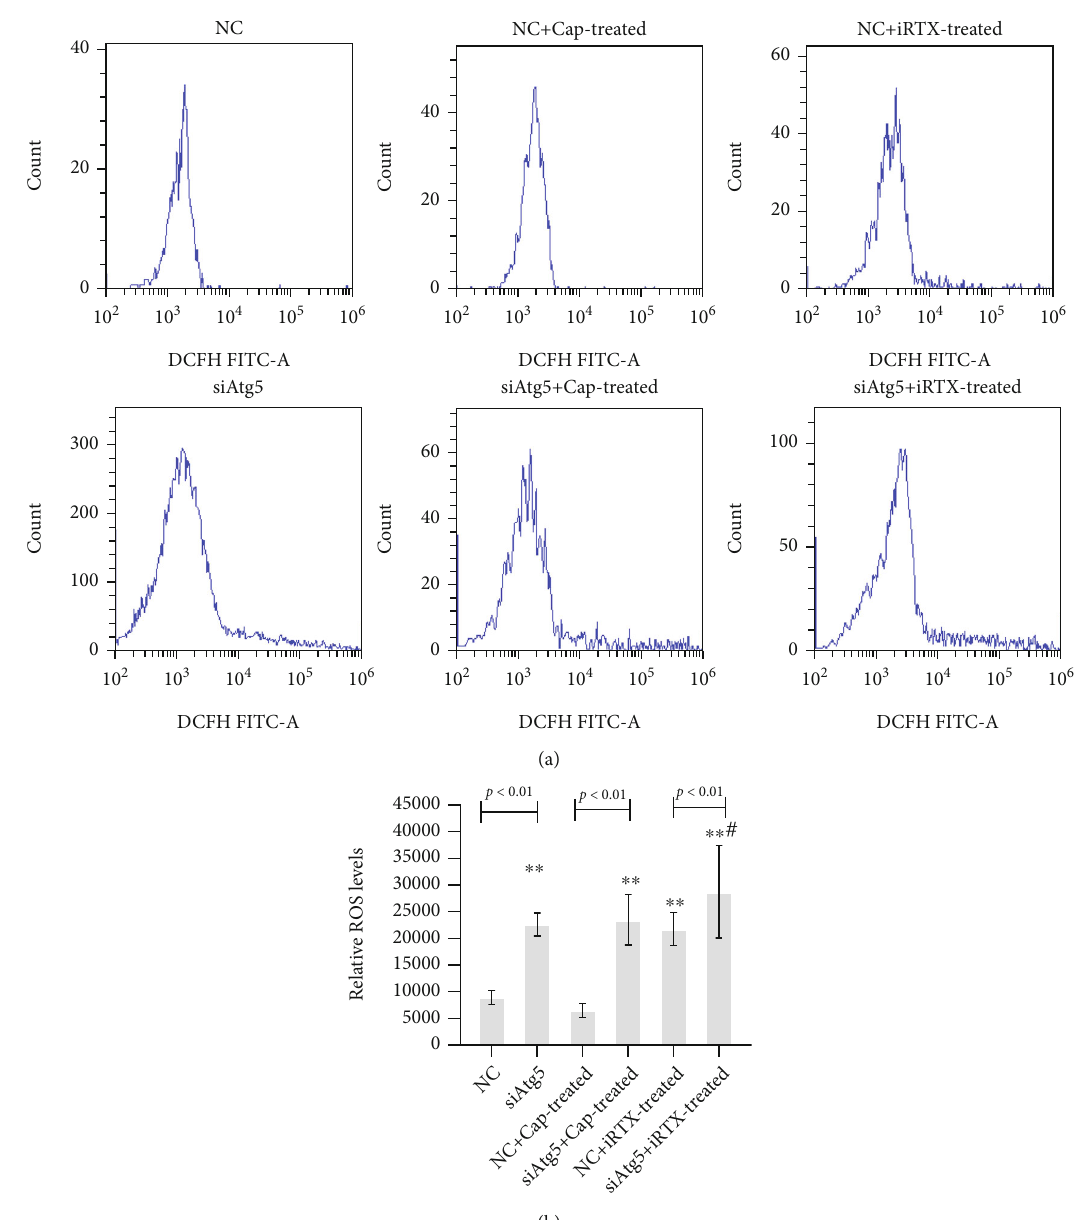
Figure 3: TRPV1 accompanied with Atg5-mediated autophagy in oxidative stress-induced microglia. The ROS level was measured in OGD/R microglia, and an autophagy-related protein of siRNA-Atg5 (siAtg5) along with negative (NC) siRNA-transfected cells, TRPV1 agonist Cap, and TRPV1 inhibitor iRTX was involved. (a) ROS level was detected using fl ow cytometry and analyzed (b). The data was given as mean ± SD , n = 3 . ∗∗ p < 0 : 01 compared with microglia in culture (control). # p < 0 : 05 compared with microglia on glucose depreciation/reoxygenation (OGD/R) culture condition